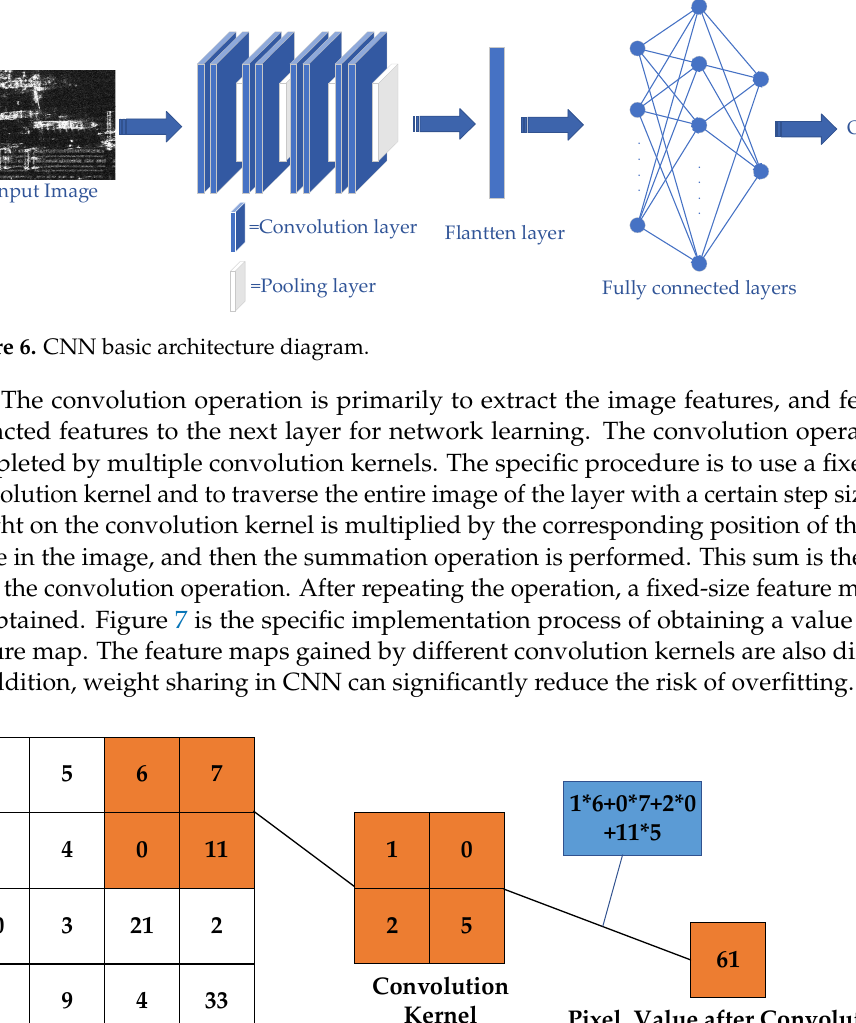
Max Pooling 2*2 Figure 8. Pooling operation diagram. The fully connected layer is composed of some interconnected neurons, which can classify and regress the input data. The classification is to classify the target or image, and the regression is mainly to regress the parameters of the bounding box. The nonlinear operation is to introduce some nonlinear activation functions into the network. The common nonlinear functions are sigmoid, tanth, ReLU functions, etc. [24]. In these four types of nonlinear activation functions, the ReLU function can avoid